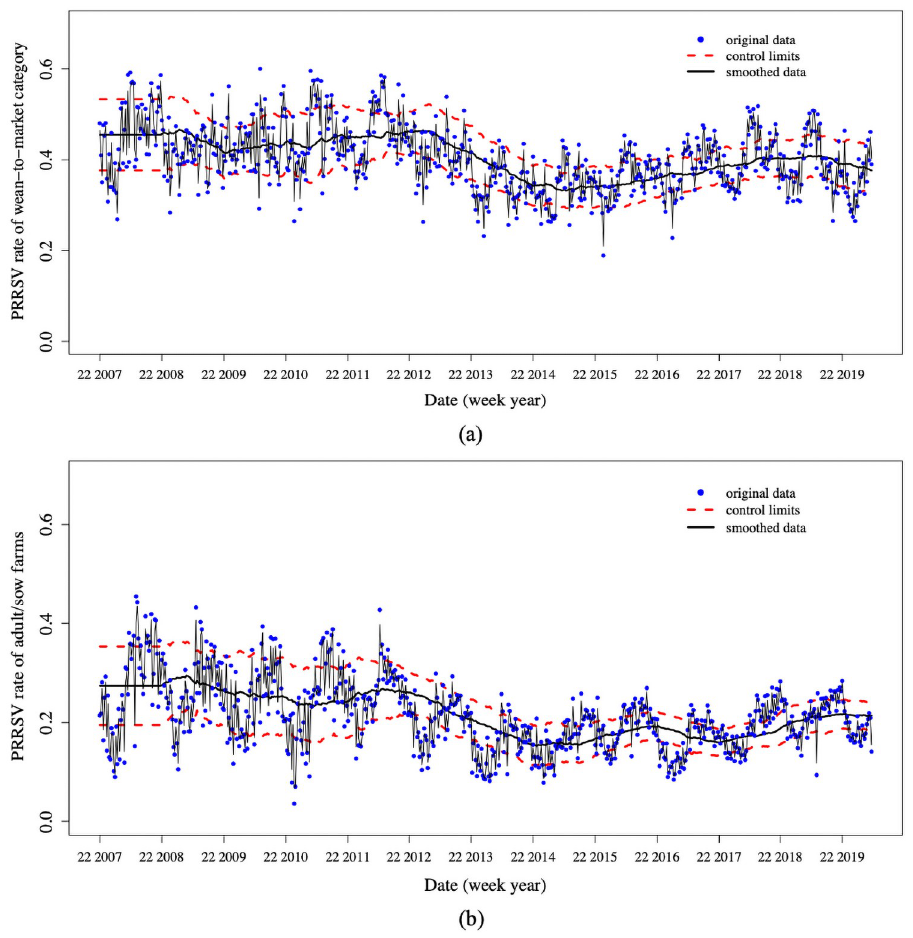
Fig 5. The dynamic EWMA control charts with a moving window having the size of 52 weeks. (a) The chart for detecting the PRRSV signals in wean-to-market categories. (b) The chart for detecting the PRRSV signals in in adult/ sow